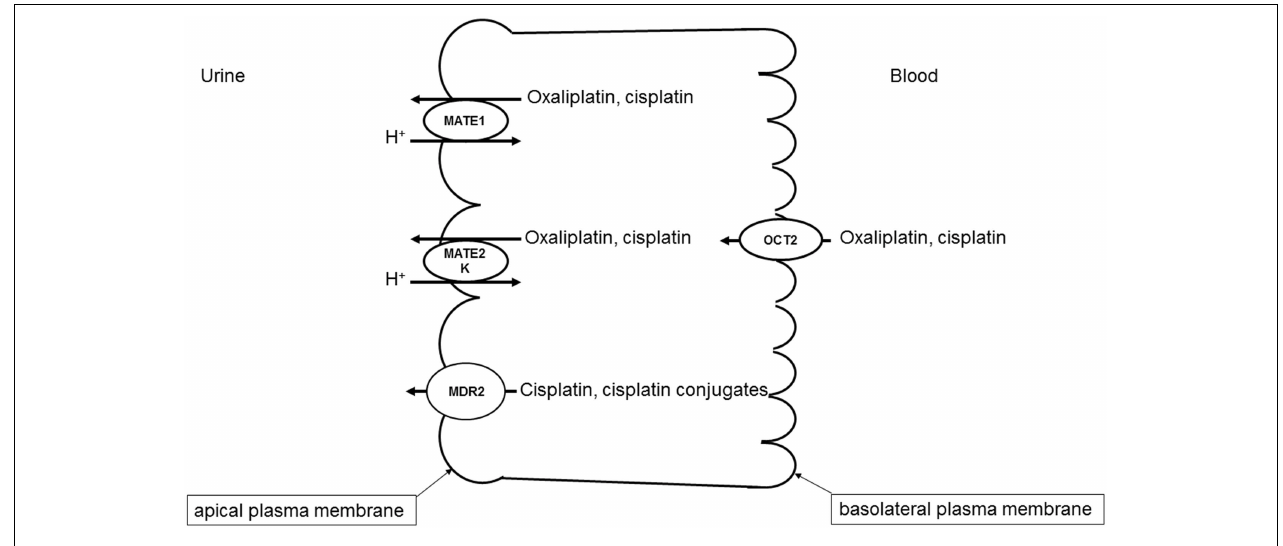
FIGURE 1 | Transport systems involved in secretion of platinum derivatives in human renal proximal tubules. Uptake of oxaliplatin and cisplatin from the blood is mediated by hOCT2 expressed in the